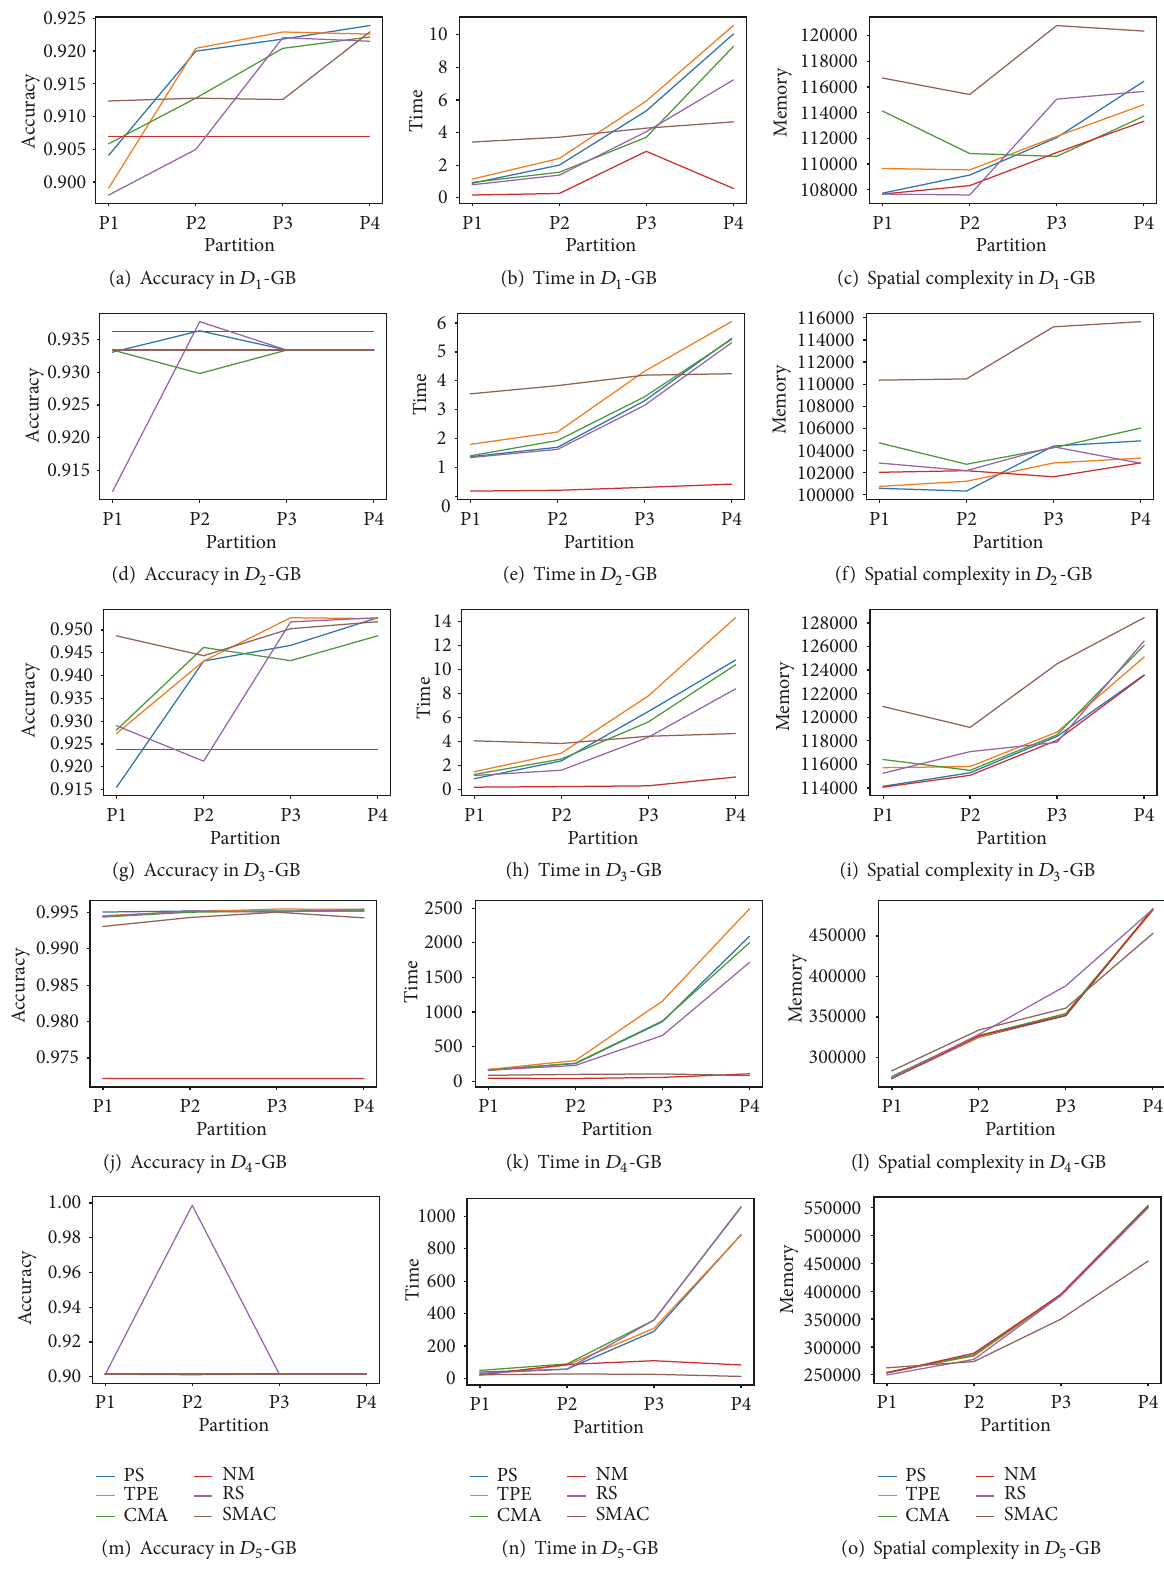
Figure 2: Accuracy, time, and spatial complexity of